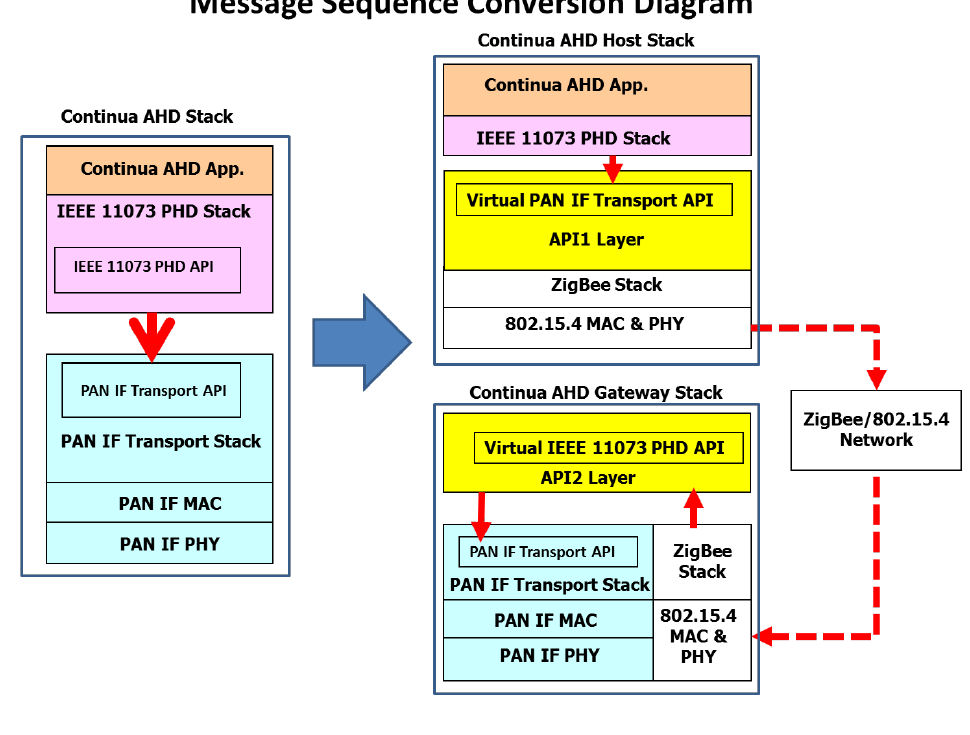
Figure 3. Message sequence conversion from IEEE 11073 PHD Stack to PAN IF Transport